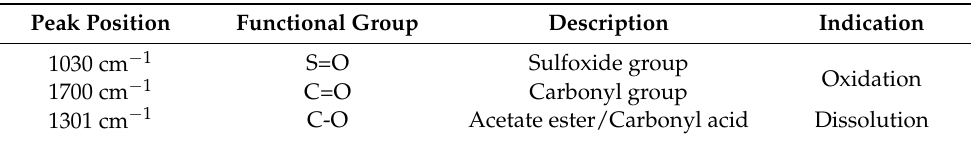
Table 4. Three typical chemical groups of the bitumen under acid rain